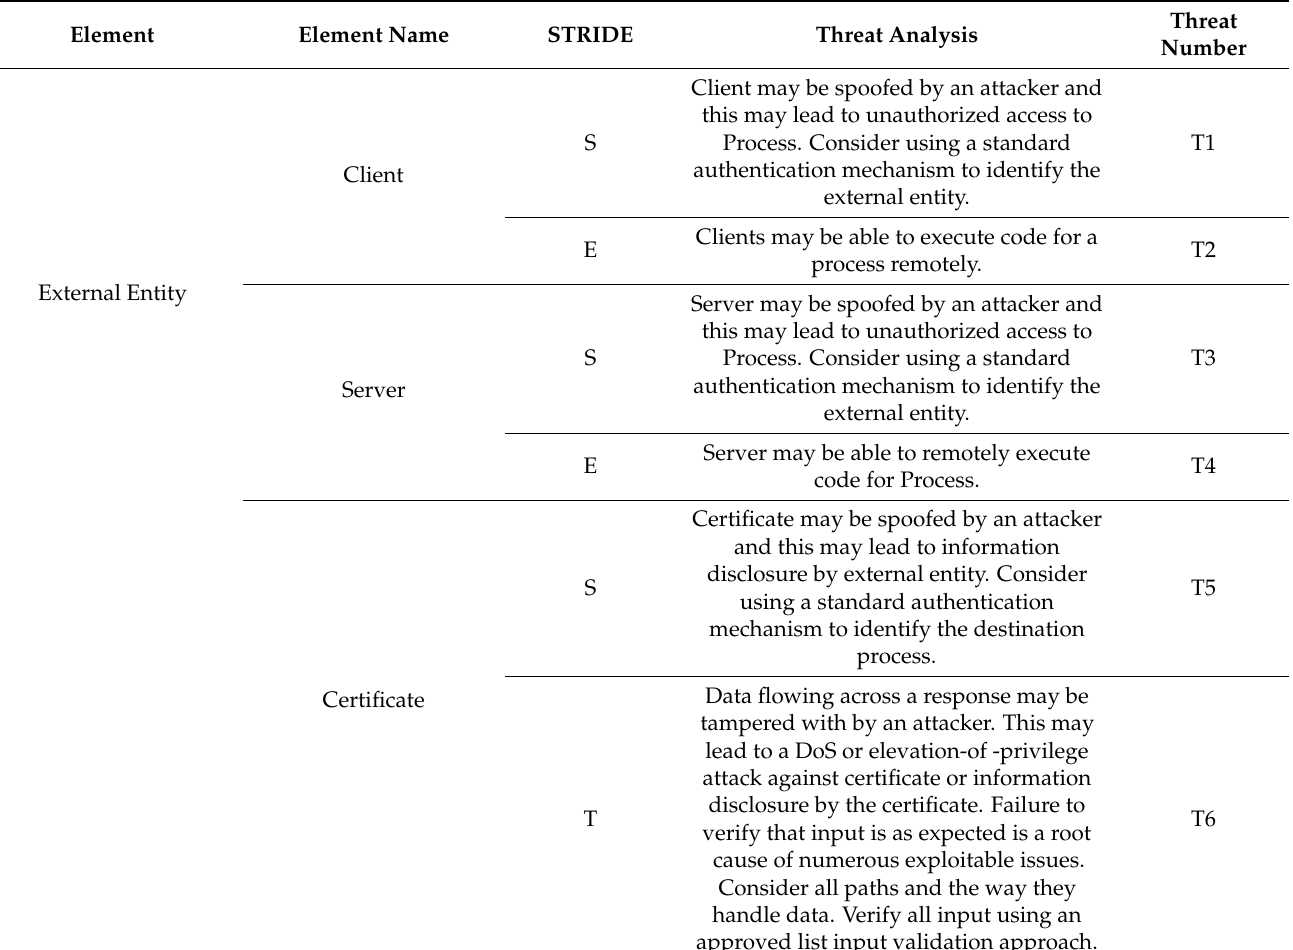
Table A1. Main threats by OPC UA